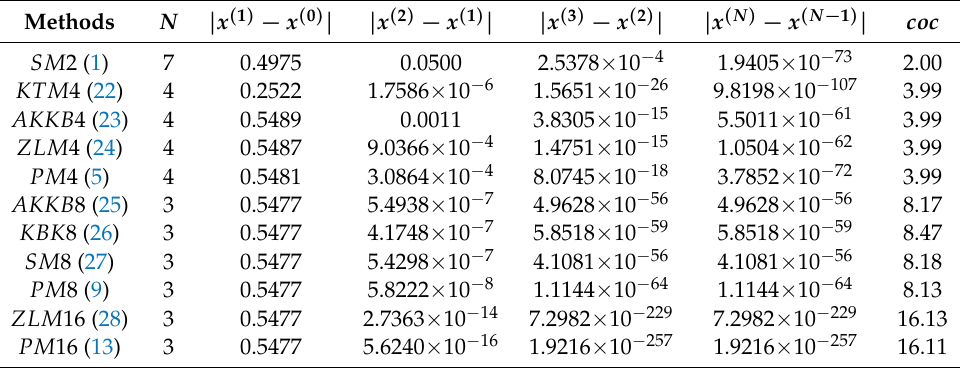
Table 4. Comparisons between different methods for f 4 ( x ) at x ( 0 ) = 1.9.